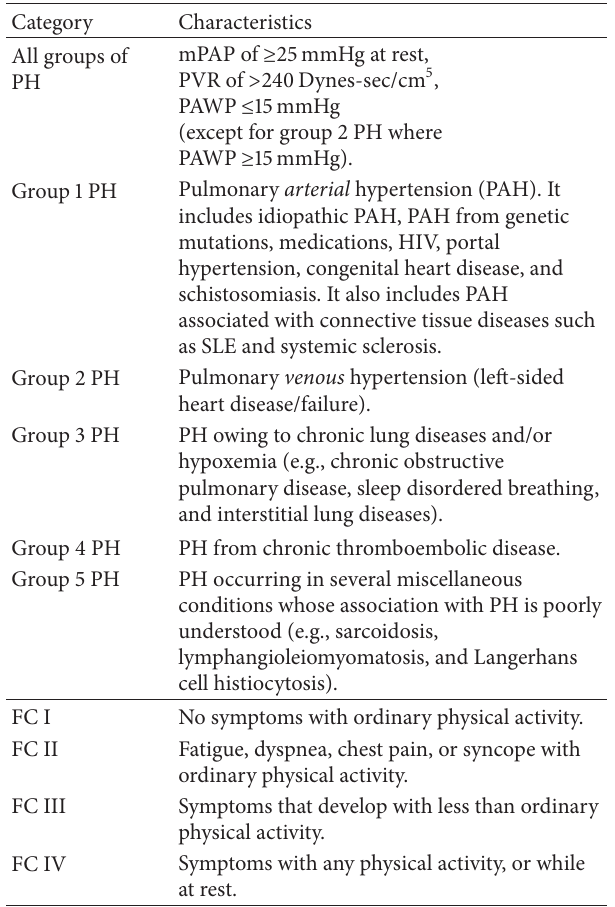
Table 1: World Health Organization (WHO) classification schemes for pulmonary hypertension (PH) and functional class (FC). The examples given for each WHO PH group are not comprehensive but offer representations of disease processes in each category. The patient in this report is group 1 PH with FC IV.